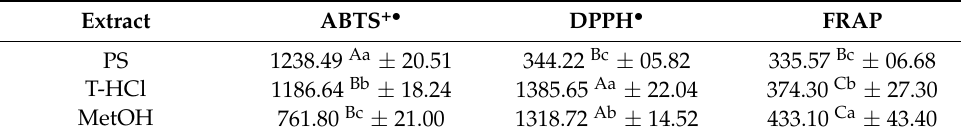
Table 6. Antioxidant activity from P. cruentum extracts ( μ mol TE·g − 1 PS).